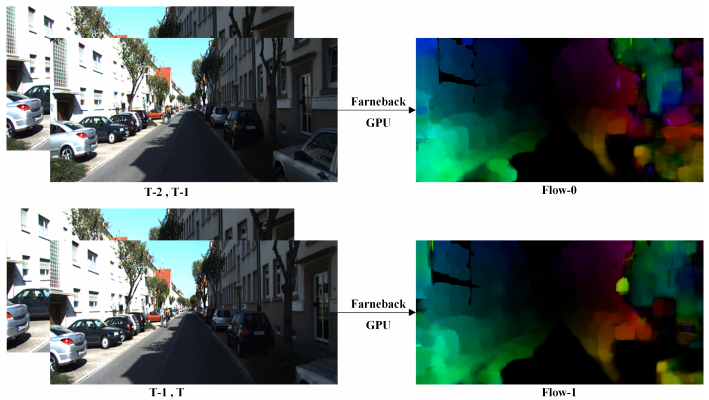
Figure 1. Optical flow from Farneback algorithm.